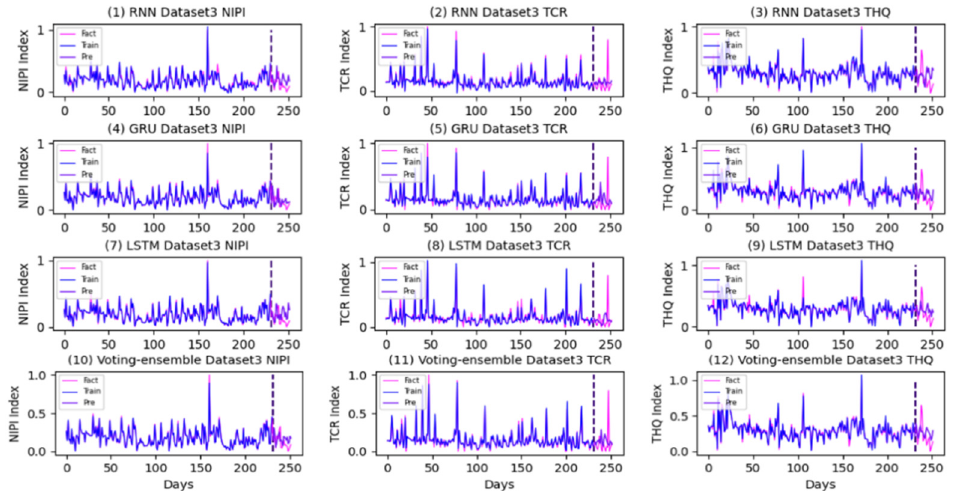
Figure 18. Prediction and actual curves generated using the RNN, GRU, LSTM, and the proposed method in Dataset3.